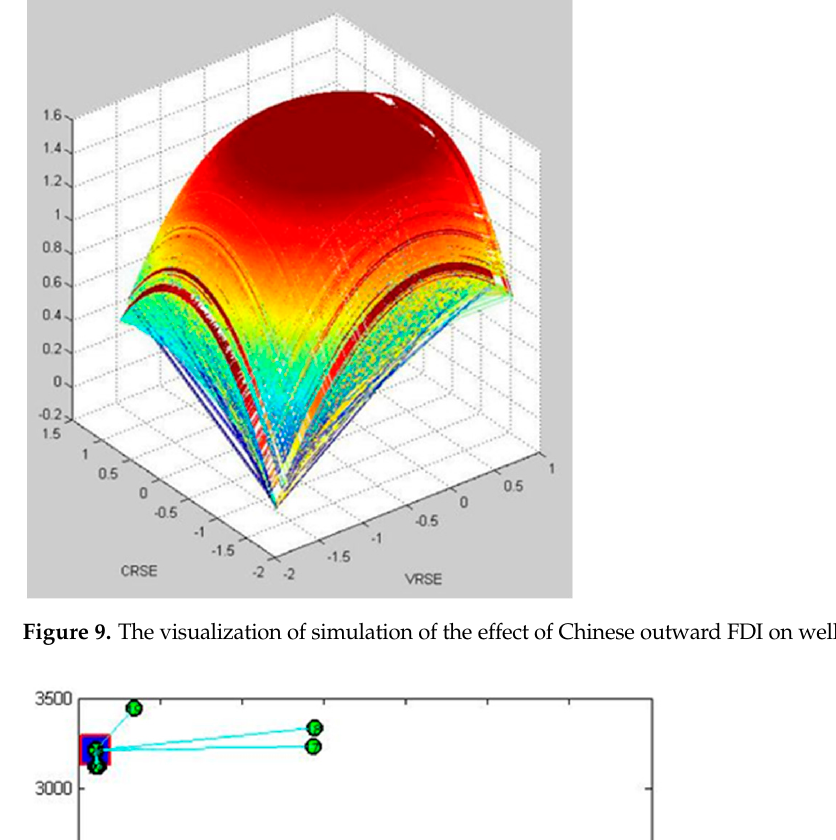
Figure 9. The visualization of simulation of the effect of Chinese outward FDI on wellbeing in Group 3.